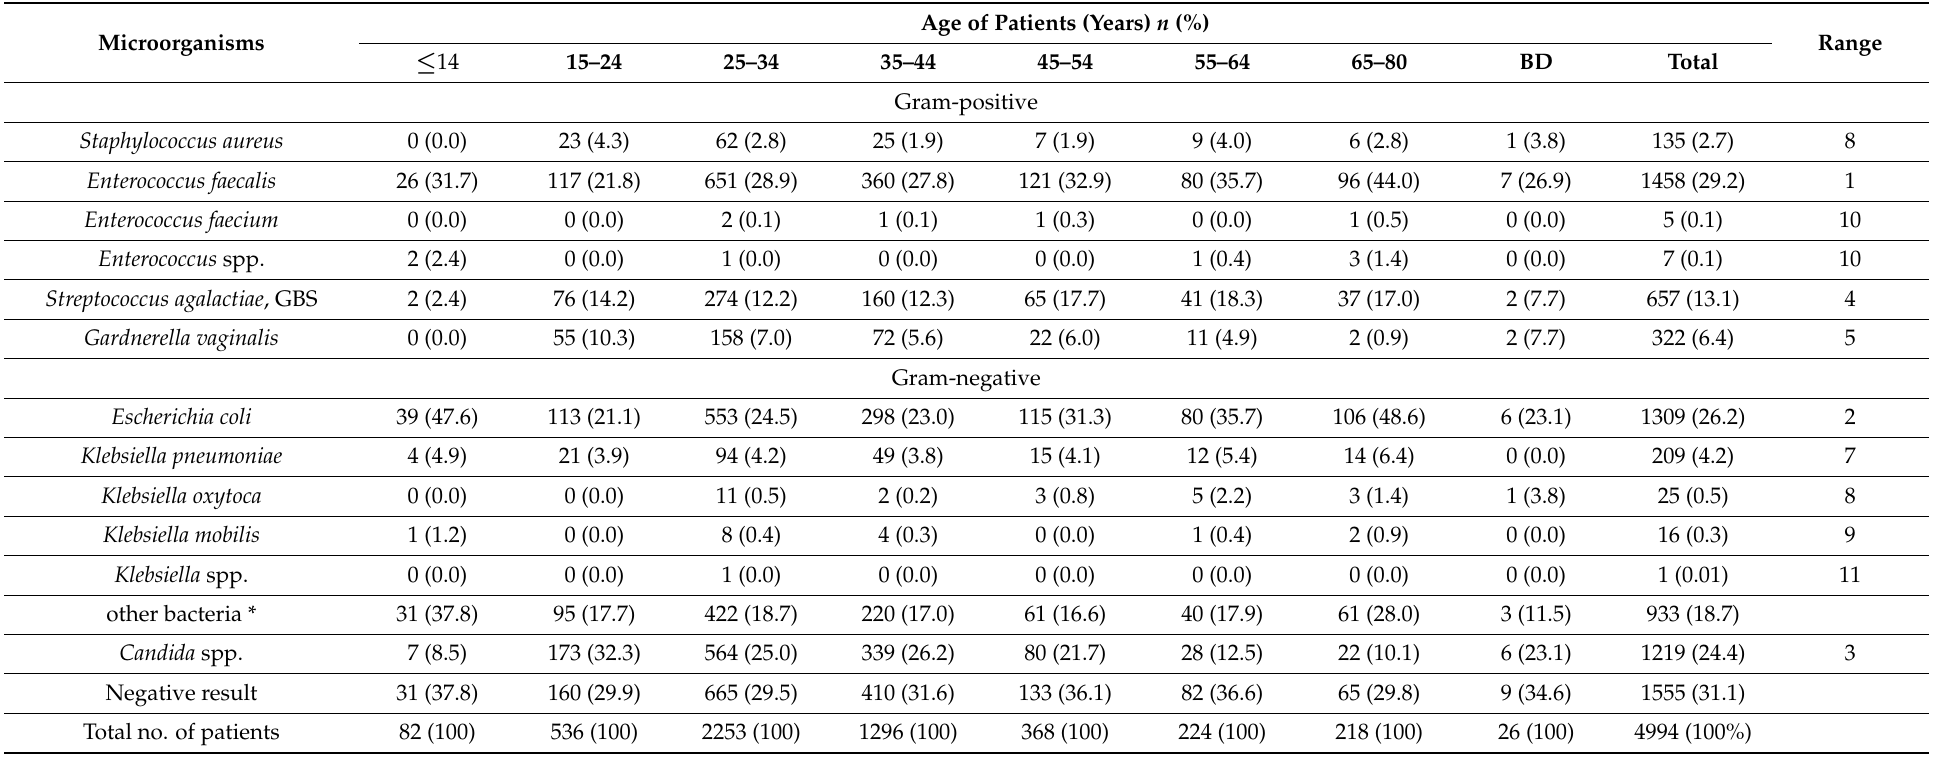
Table 1. Distributions of the microorganisms in infections of the female reproductive tract in women from the south of Poland.